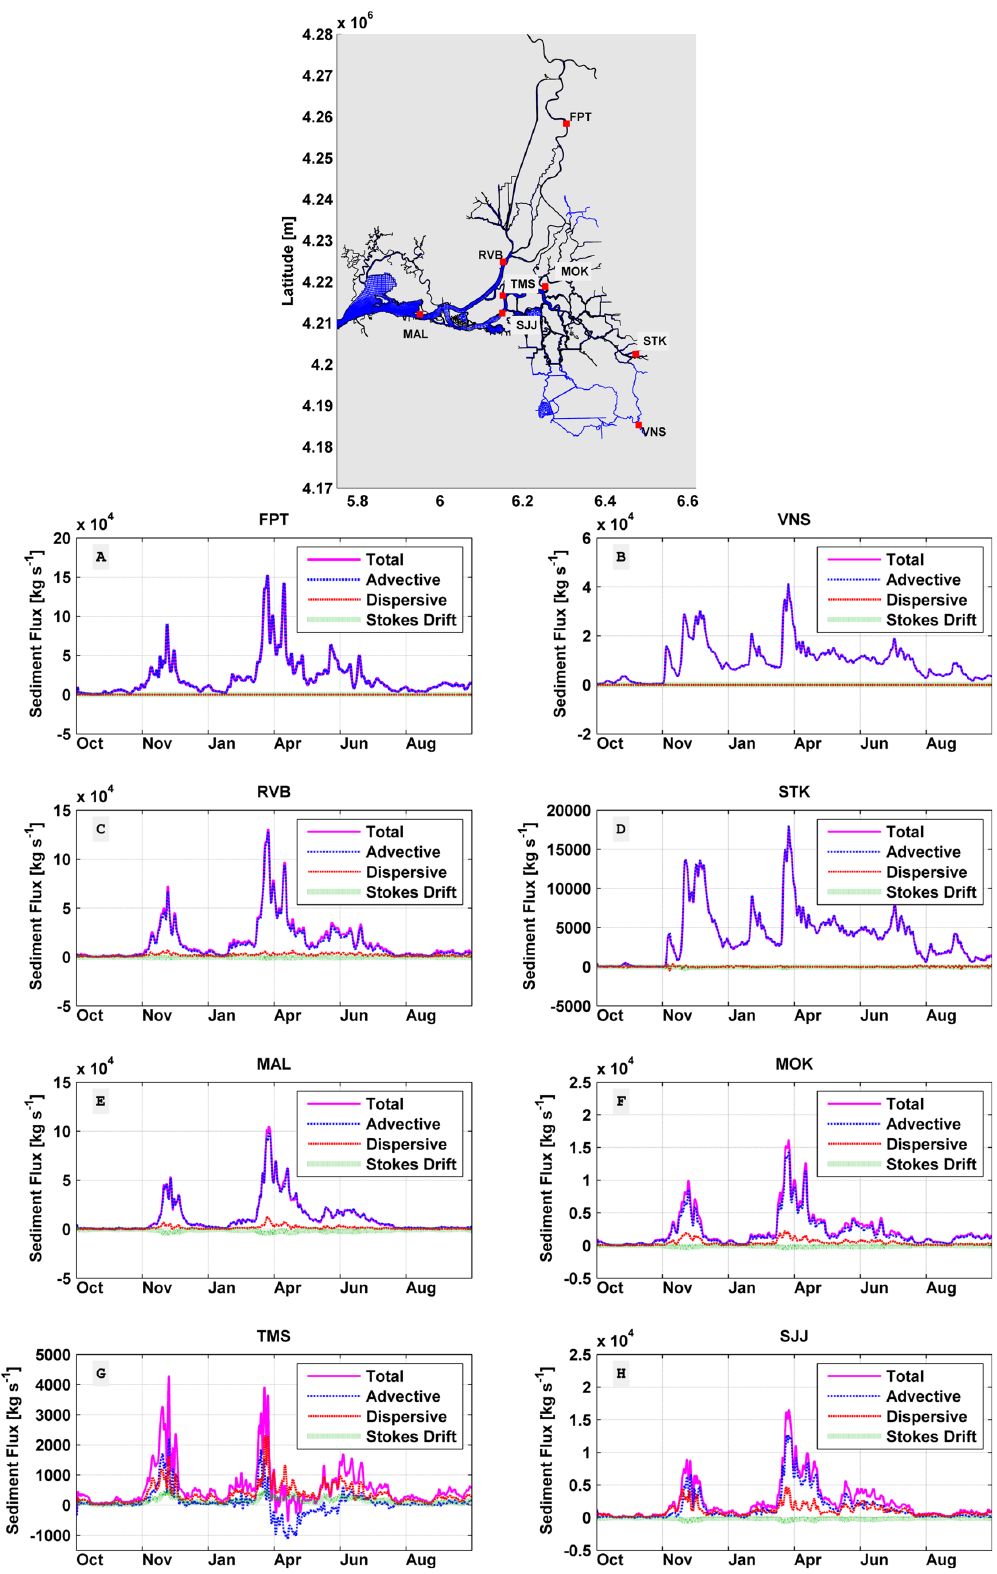
Figure 10. Sediment flux calculations for several stations within the Delta. (a) , (c) , (e) and (g) show the sediment flux change following the Sacramento branch and (b) , (d) , (f) and (h) following the San Joaquin branch. The total flux is represented in magenta, advective flux in blue, dispersive flux in red and Stokes drift in green. The total and advective sediment fluxes are the same at FPT and VNS. Positive is seaward. Hydrol. Earth Syst. Sci., 19, 2837–2857, 2015